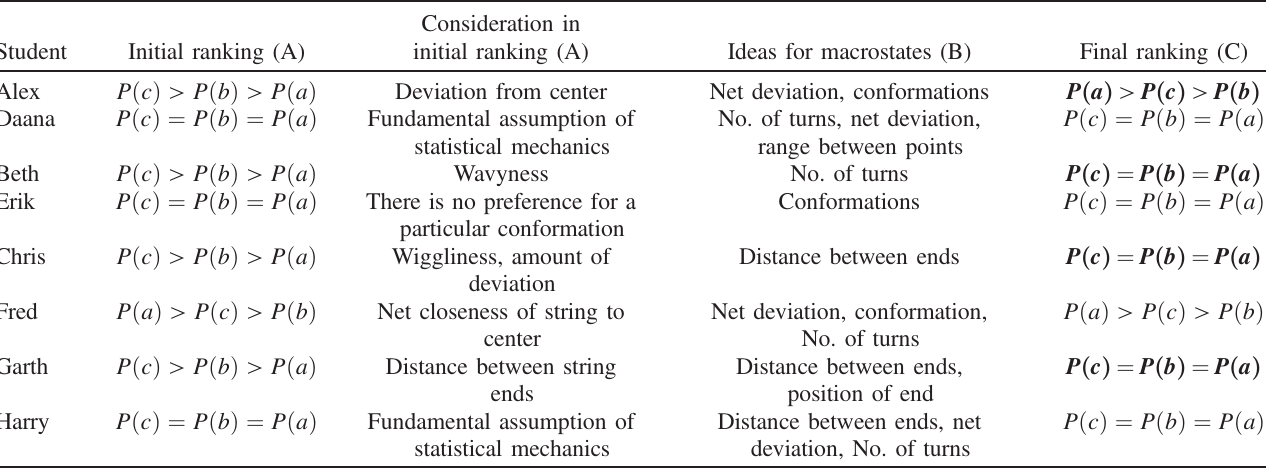
TABLE IV. Summary of graduate student responses to parts A, B, and C of the strings question (third question of the interview). Letters in parentheses on title row refer to prompts in Fig. 2. Bold entries in the final column indicate rankings that changed after students considered macrostates and microstates.